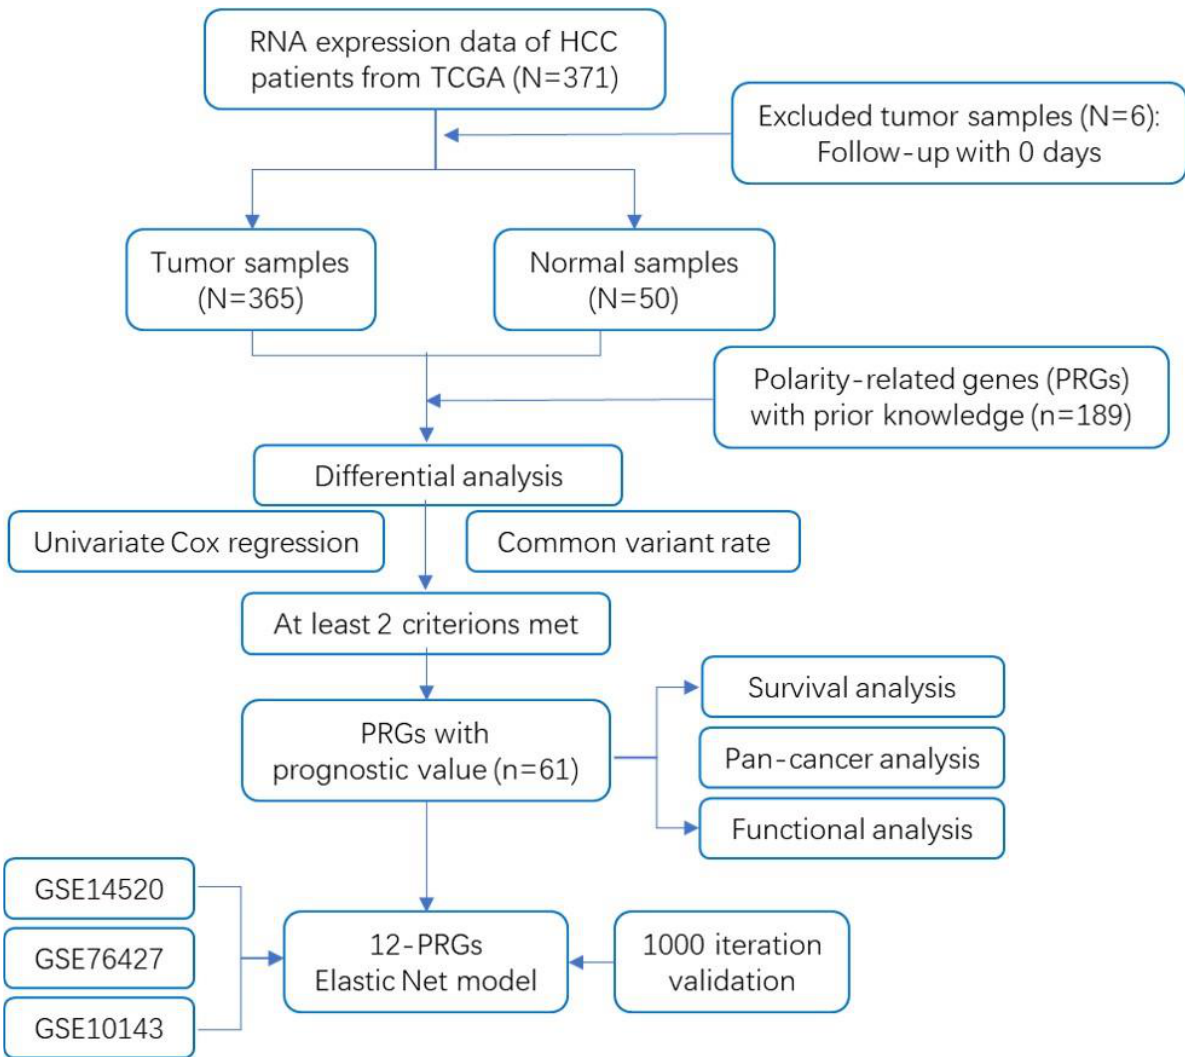
Figure 1. Flowchart of data collection and analysis.